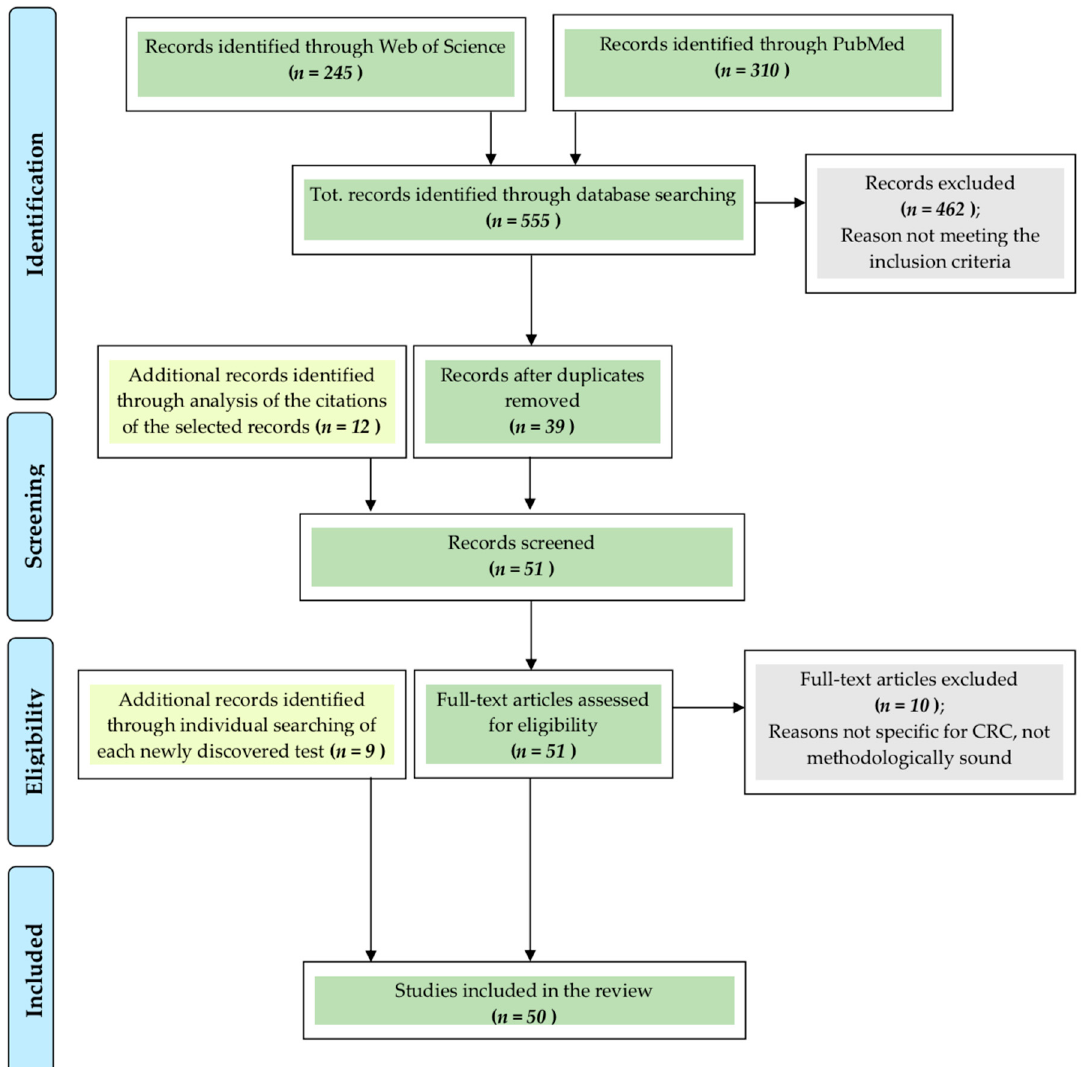
Figure 1. Methods. CRC = colorectal cancer.